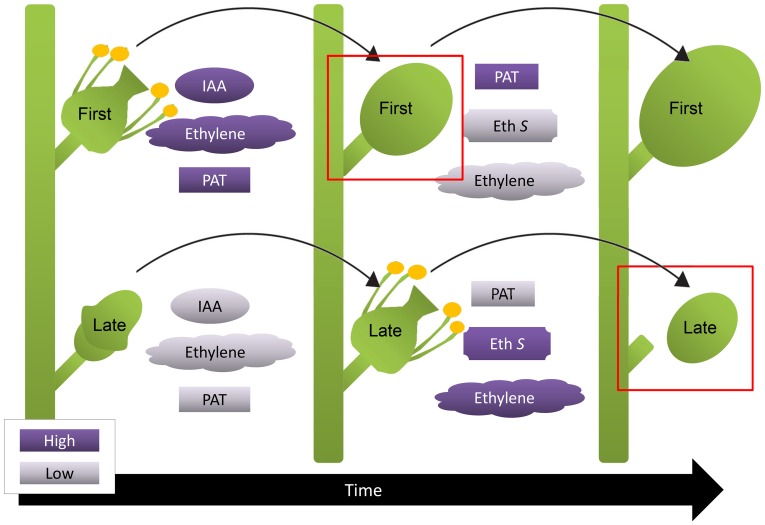
Proposed model for explaining differences in abscission between “first berries” and “late berries”.Flowering is associated with IAA and ethylene content increase, so flowers that open first may have higher content of these hormones than unopened flowers. IAA activates polar auxin transport (PAT), as shown in many plant species, so we propose that flowers that will originate “late berries” may have lower PAT than flowers that will originate “first berries”, and as a consequence “late berries” may have higher ethylene sensitivity (Eth S), which is associated with the activation of ethylene responses, such as the abscission zone formation. “First berries” should be unaffected by ethylene since they have high PAT and this might explain why abscission rate is lower in “first berries” than in “late berries”, when they are compared at the same developmental stage (red outlined boxes).